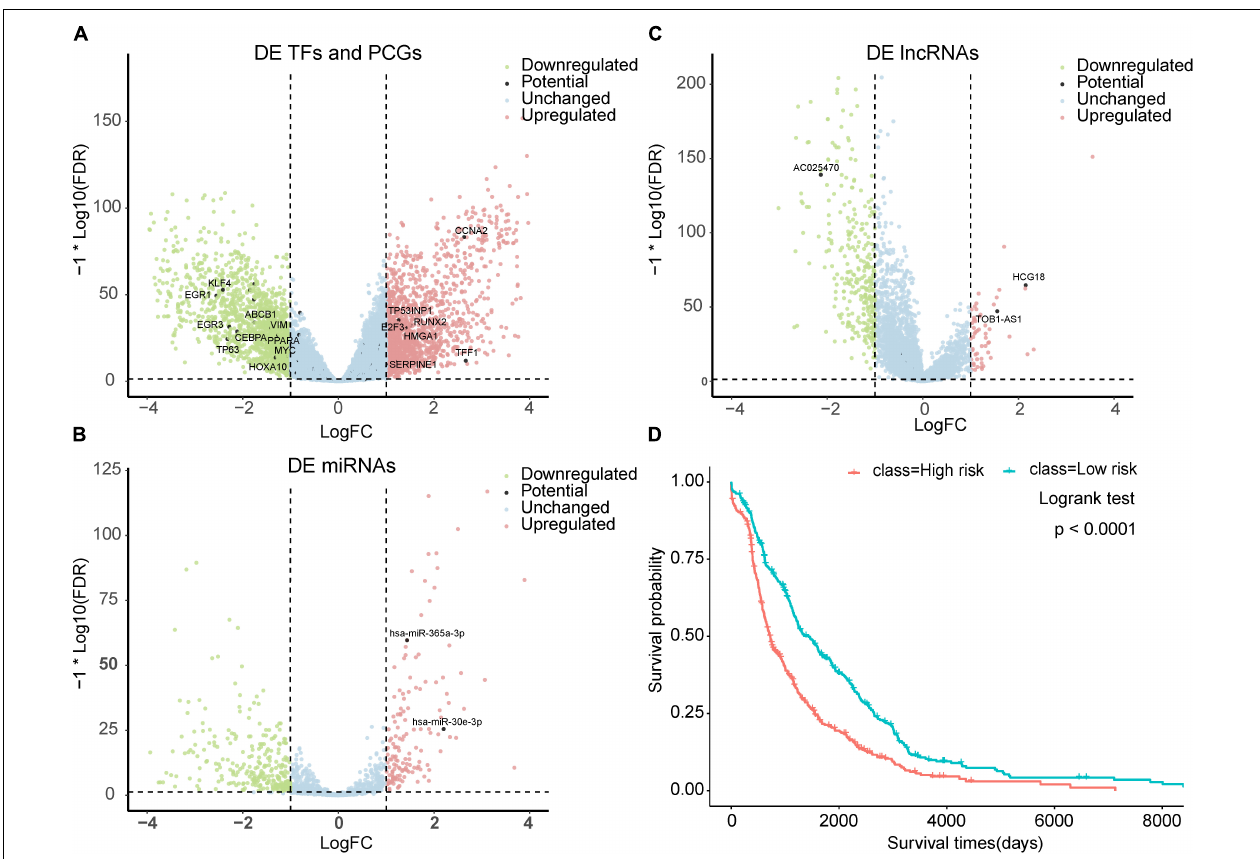
FIGURE 4 | Prioritized BC-associated factors are potential prognostic biomarkers. (A) Volcano plot for the DE genes of BC. The top-ranked TFs and PCGs that differentially expressed were marked. (B) Volcano plot for the DE miRNAs of BC. The top-ranked miRNAs that differentially expressed were marked. (C) Volcano plot for the DE lncRNAs of BC. The top-ranked lncRNAs that differentially expressed were marked. (D) Kaplan–Meier analysis for overall survival of patients with high-risk or low-risk scores. P -value was calculated using the two-sided log-rank